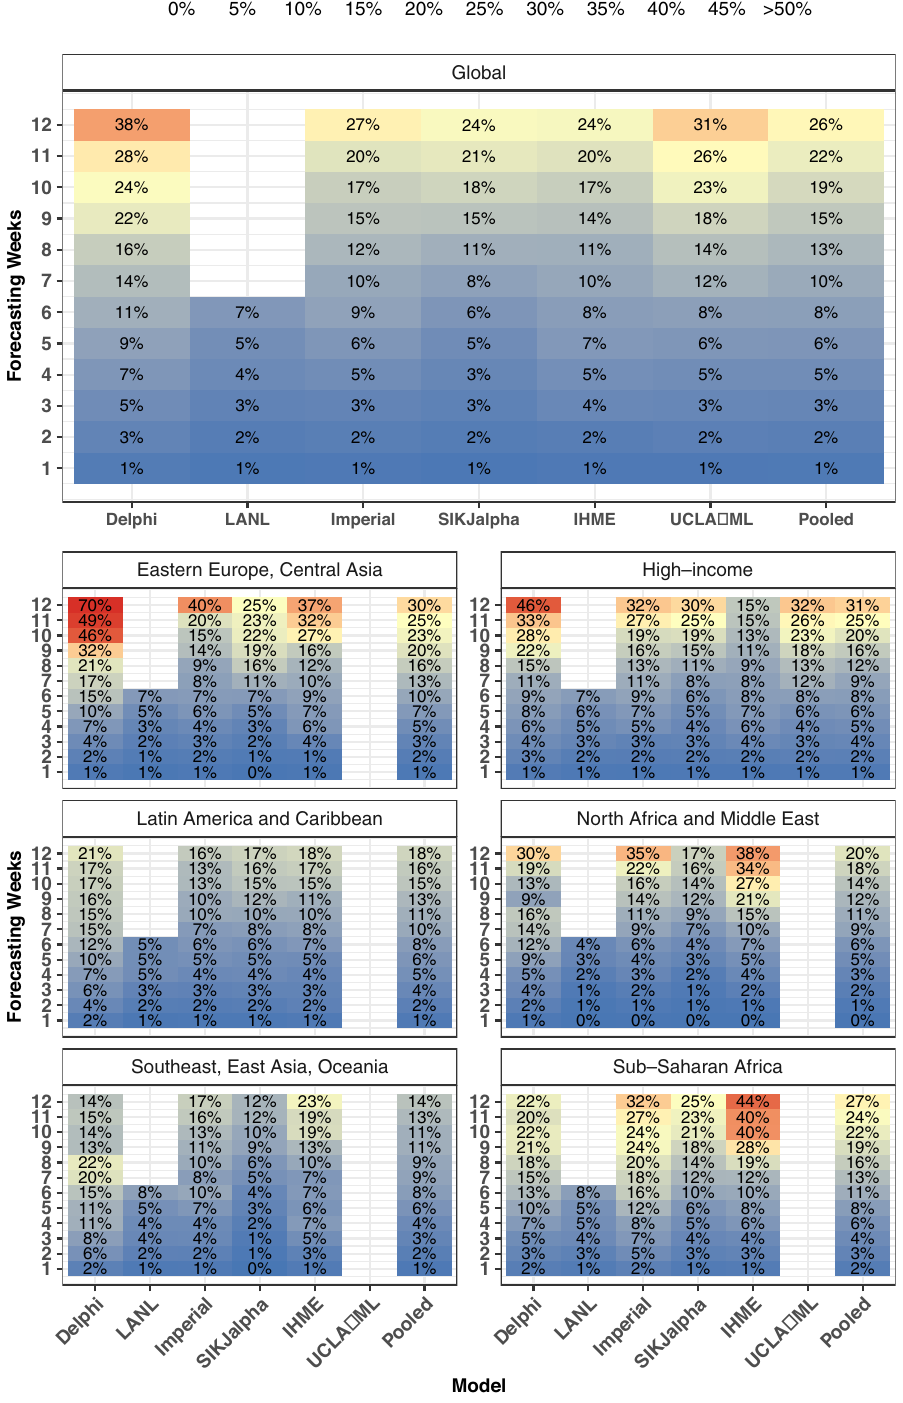
Fig. 3 Most current — cumulative mortality accuracy — median absolute percent error. Median absolute percent error values, a measure of accuracy, were calculated across all observed errors at weekly intervals, for each model by weeks of forecasting and geographic region. Values that represent fewer than fi ve locations are masked due to the small sample size. Models were included in the global average when they included at least fi ve locations in each region. Pooled summary statistics re fl ect values calculated across all errors from all models, in order to comment on aggregate trends by time or geography. Results are shown here for the most recent 4-week window allowing for the calculation of errors at each point of extrapolation (see Fig. 2 and “ Methods ” ). Results from other months are shown in the Supplementary Information. The colour re fl ects 50 for values above 50 to prevent extreme values obscuring the